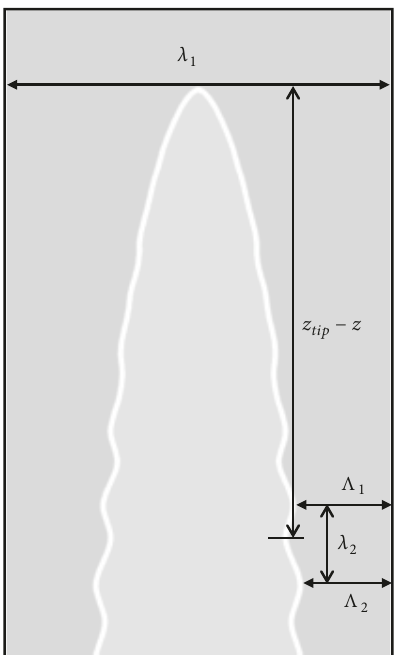
Figure 1: Sketch of sidebranches and parameters definition in the derivation of scaling law, where 𝜆 1 is primary spacing, 𝜆 2 is the sidebranch spacing, Λ 1 and Λ 2 are groove width, and 𝑧 𝑡𝑖𝑝 is the tip position along 𝑧